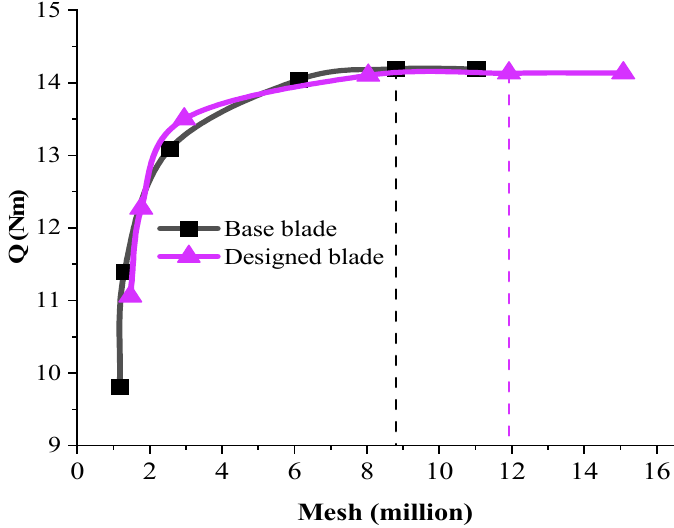
Figure 15. The grid-independency test results.